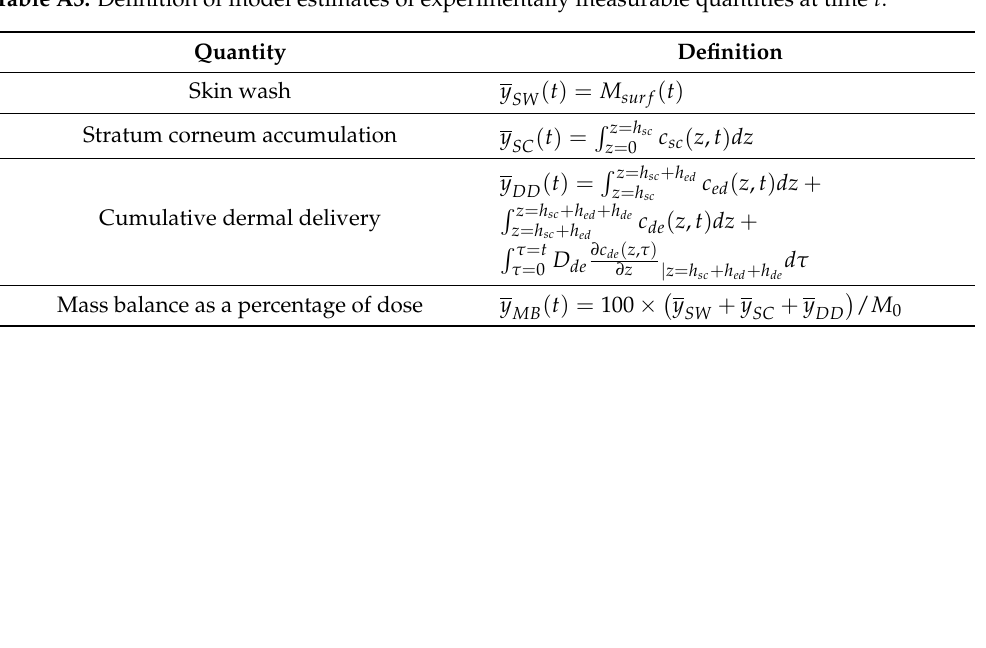
Table A3. Definition of model estimates of experimentally measurable quantities at time t